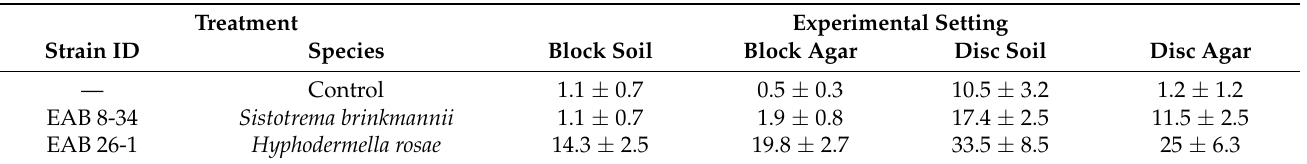
Figure 6. Boxplot of the percentage of weight loss for sapwood discs in the agar microcosm. Different letters represent statistical differences between treatments ( p < 0.01). Table 2. Mean percentage of weight loss ± standard deviation, for all treatments under each experimental setting.